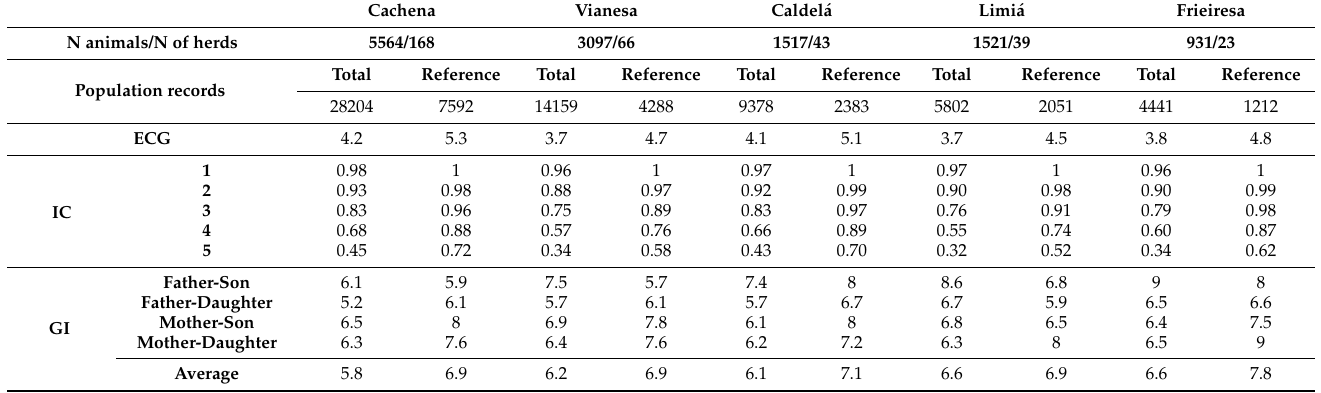
Table 1. Pedigree records of the five Galician bovine breeds. N animals are the live animals registered in the herdbook of each breed in 2021. ECG: Equivalent Complete Generation; IC: Index of complete- ness from generation 1 to 5; GI: Generation Interval. Reference population refers to those animals born since 2017 to